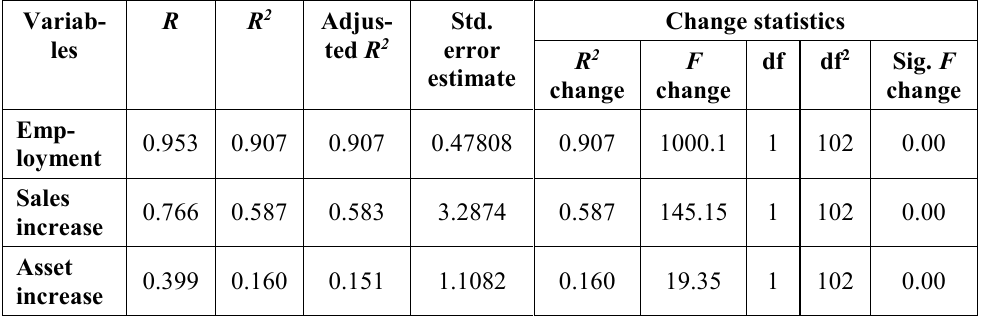
Table 5. Model Summary of the Relationship between Dependent and